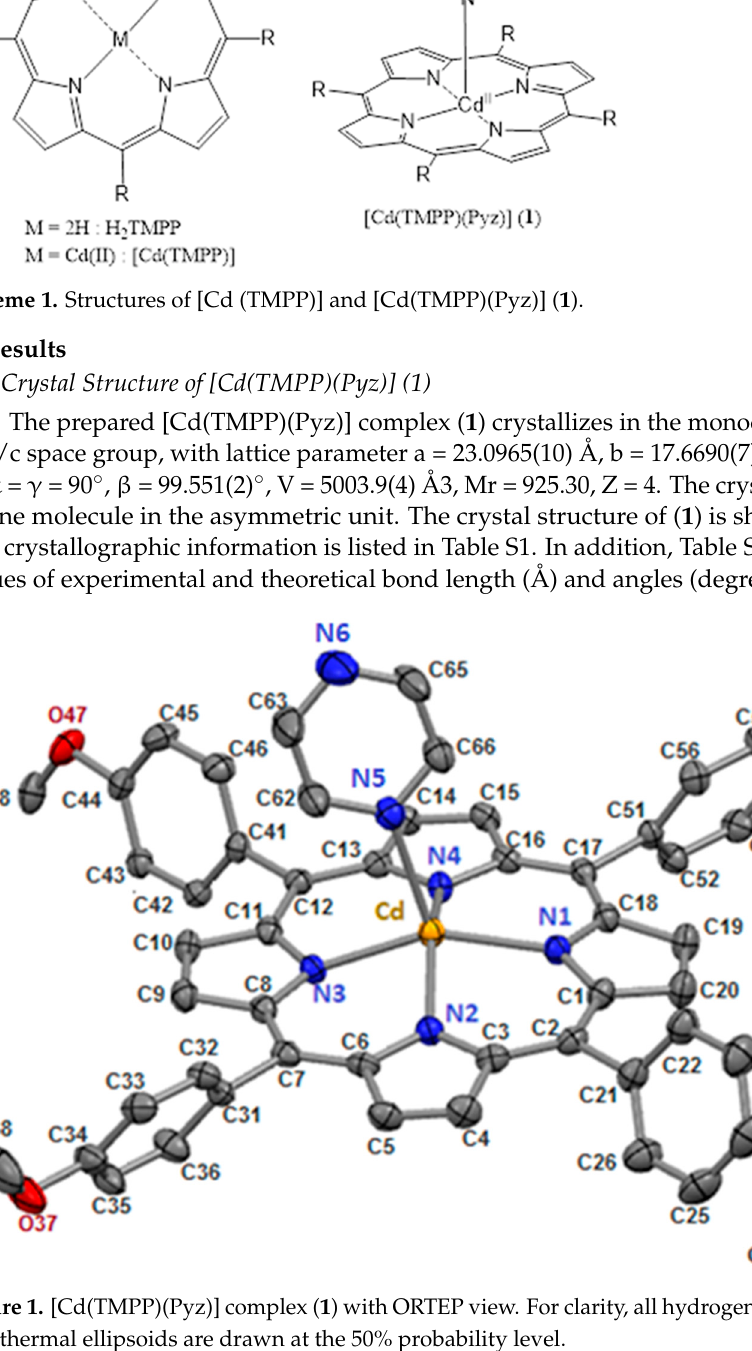
Figure 1. [Cd(TMPP)(Pyz)] complex ( 1 ) with ORTEP view. For clarity, all hydrogen atoms are omit- ted, and thermal ellipsoids are drawn at the 50% probability level.